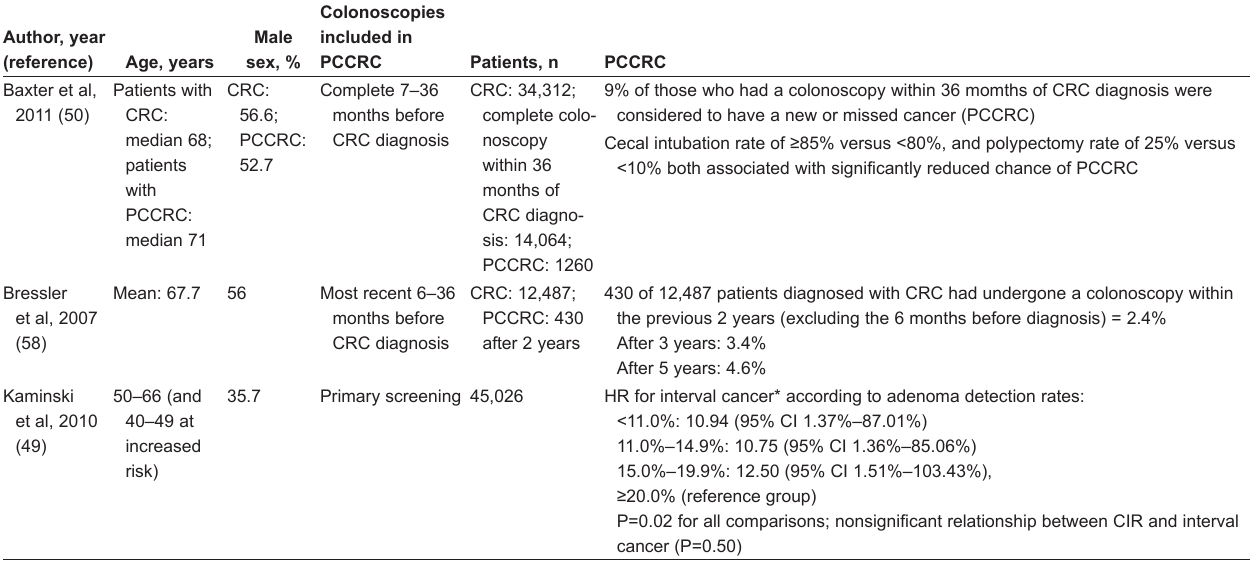
TAble 8 Study outcomes, postcolonoscopy colorectal cancer